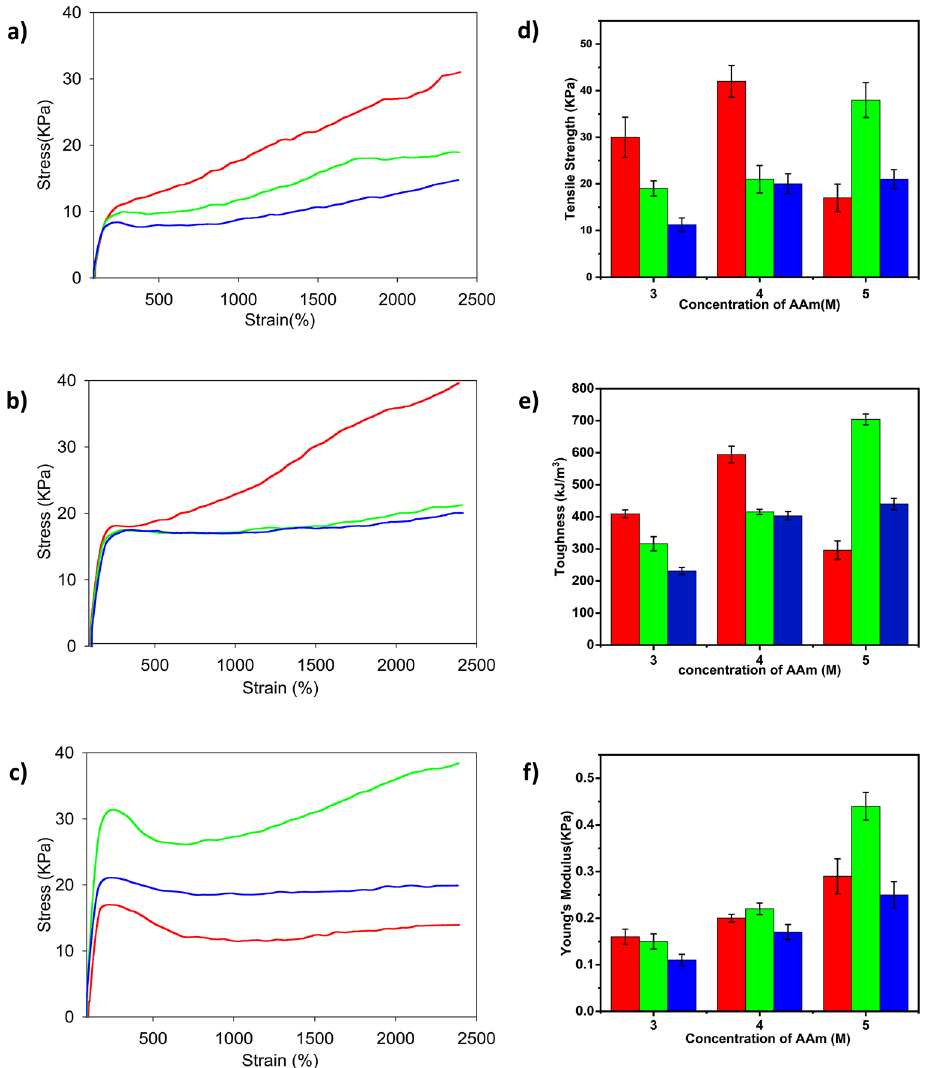
Figure 7. Stress–strain curves produced by tensile strength test of PAAm (3 M)-MSiO 2 0.75% ( a ), PAAm (4 M)-MSiO 2 0.75% ( b ), and PAAm (5 M)-MSiO 2 0.75% ( c ), hydrogels and comparison of tensile strengths ( d ), toughness ( e ), and Young’s modulus ( f ) of PAAm (3 M)-MSiO 2 0.75%, PAAm (4 M)-MSiO 2 0.75%, and PAAm (5 M)-MSiO 2 0.75 hydrogels. Red, green, and blue colors represent MSiO 2 cross-linker having a diameter of 117.5 nm, 216.5 nm, and 311.5 nm, respectively.